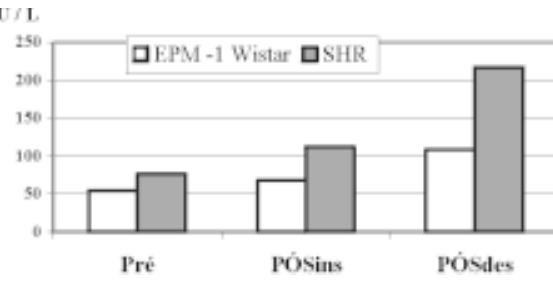
FIGURA 4 - N(cid:237)veis sang(cid:252)(cid:237)neos de ALT, representados pelas medianas dos valores, para cada linhagem de rato, nos diferentes momentos de avalia(cid:231)ªo, com uma pressªo de 10mmHg de